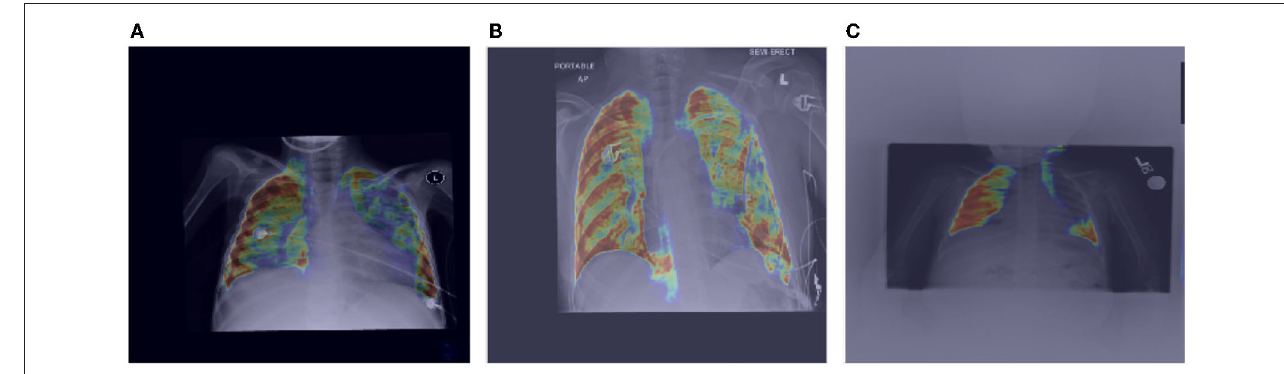
FIGURE 6 | Impact of MEDUSA global attention on the images with distortion. The images (A–C) are corresponding to images (A–C) in Figure 5